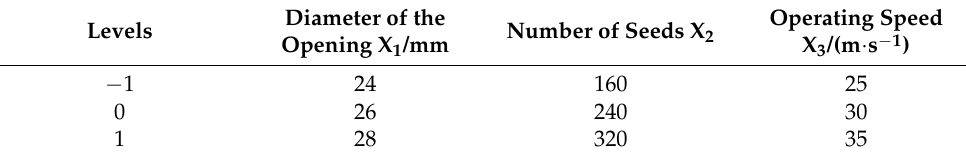
Table 4. Factors and levels of test. Levels